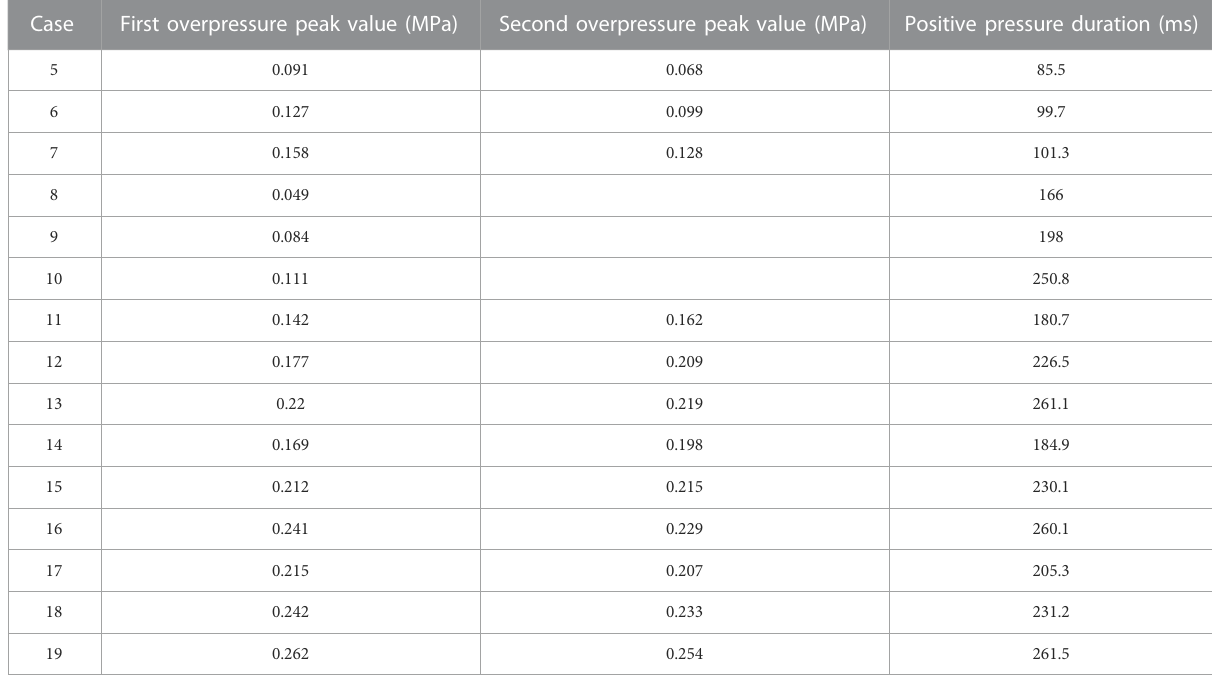
TABLE 4 Results of cases at gauging point 1 with three drive methods.